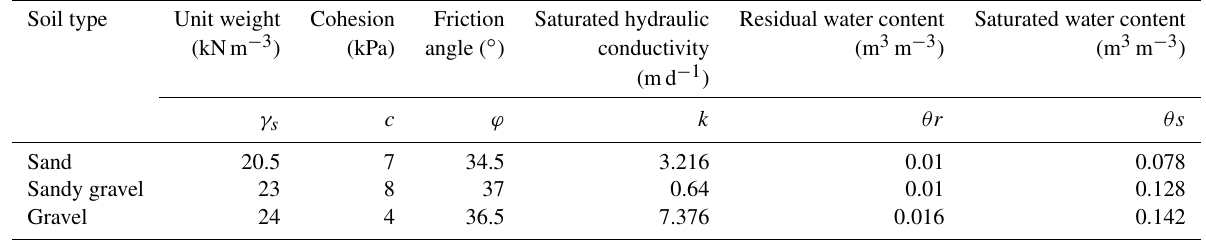
Table 1. Mechanical and hydraulic soil properties used in slope stability modelling. Soil type